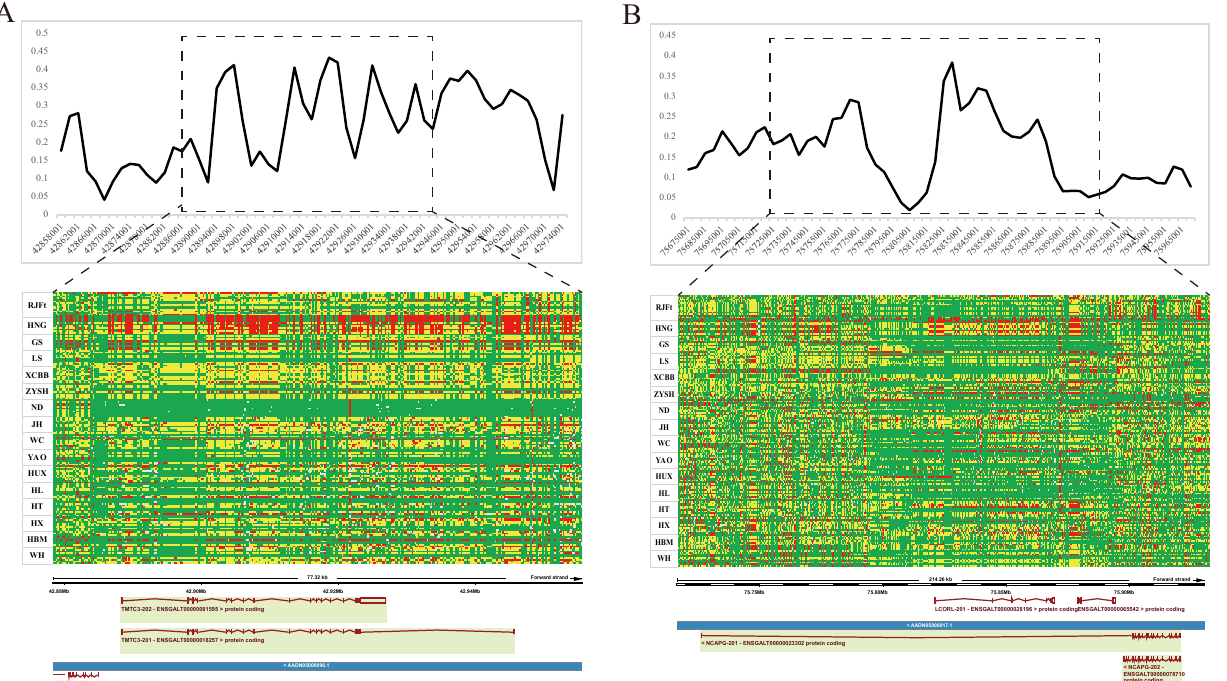
Figure 6. Selective sweeping signatures of TMTC3 , LCORL, and NCAPG genes in gamecock chickens. ( A ) FST analysis and haplotype diversity of TMTC3 genes between gamecock populations and the other non-gamecock chickens. ( B ) FST analysis and haplotype diversity of NCAPG and LCORL genes between gamecock populations and the other non-gamecock chickens. Red, yellow, and green represent homozygous mutant, heterozygous mutant, and homozygous wild-type, respectively.